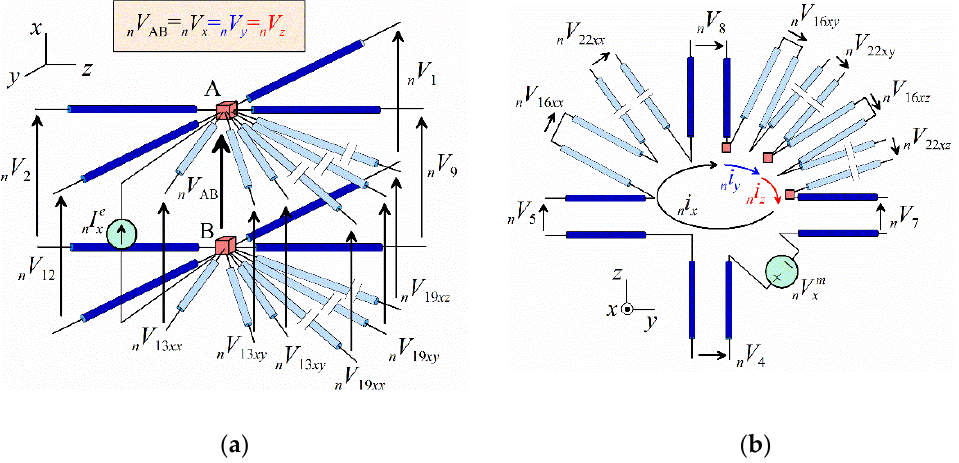
Figure 2. ( a ) The Shunt node for E x at time t n . Link lines represented in dark blue are connected to adjacent nodes. In pale blue: lines 13 xj are open stubs and lines 19 xj are infinitely long stubs. The red boxes at terminals AB denote a formal connection indicating that voltage V AB at common terminals AB is n V x for the link lines and for lines 13 xx and 19 xx , n V y for lines 13 xy and 19 xy , and n V z for lines 13 xz and 19 xz . ( b ) The series node for H x at time t n . Link lines, represented in dark blue, are connected to adjacent nodes. In pale blue: lines 16 xj are short-circuited stubs, while lines 22 xj are infinitely long stubs. The red boxes denote a formal connection indicating that the current is n i x for the link lines and lines 16 xx and 22 xx , n i y for lines 16 xy and 22 xy , and n i z for lines 16 xz and 22 xz .